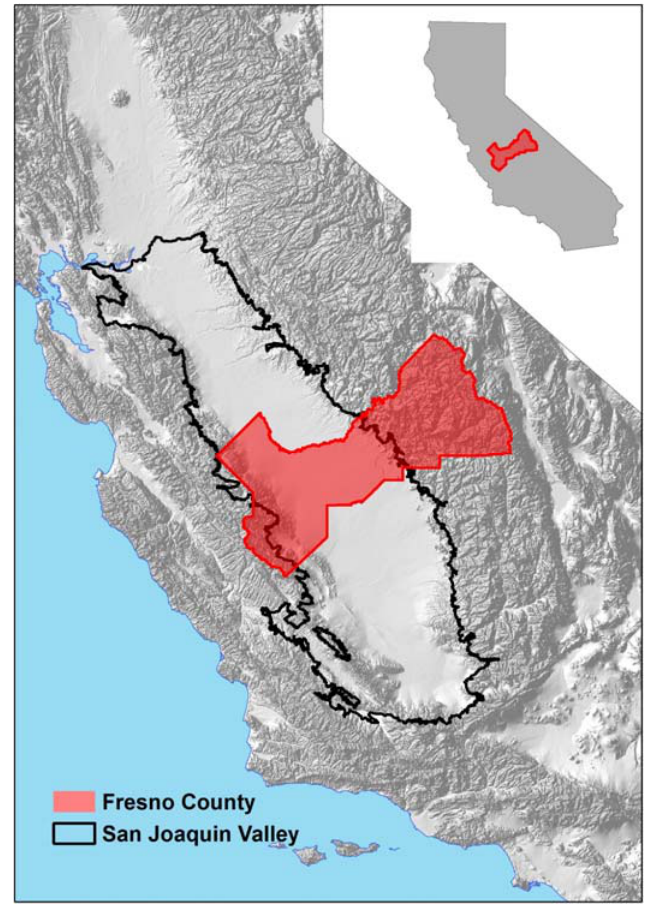
Map created by Patrick